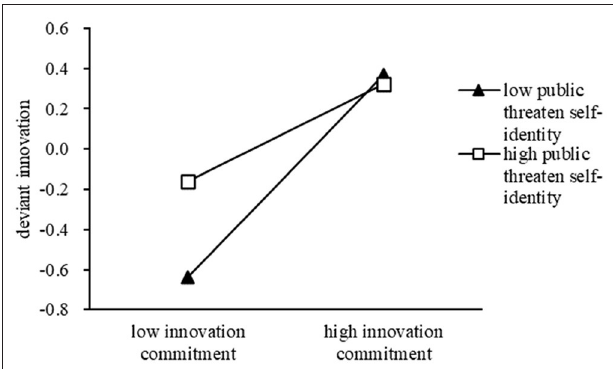
FIGURE 2 | Moderating effect of public threat to self-identity on the relationship between innovation commitment and deviant innovation